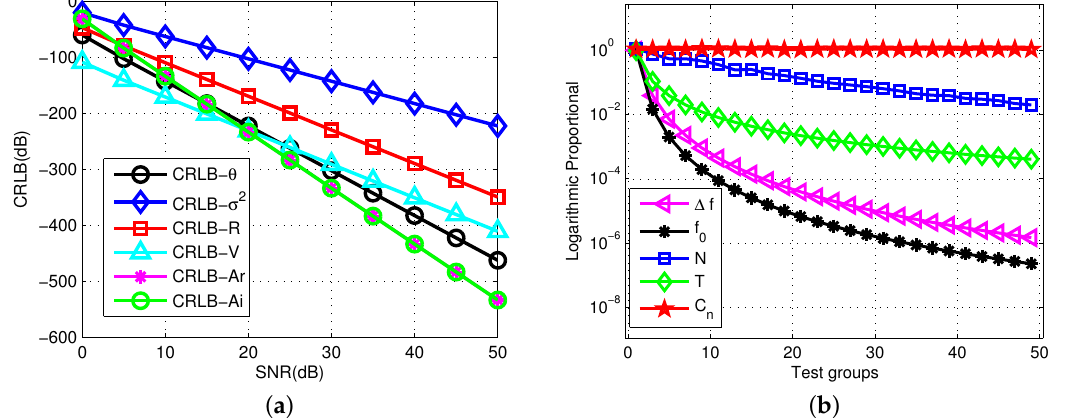
Figure 3. Comparison of CRLBs with changing SNR. ( a ) Monte Carlo Comparison of CRLBs; ( b ) Monte Carlo simulation of CRLB- θ with multiple